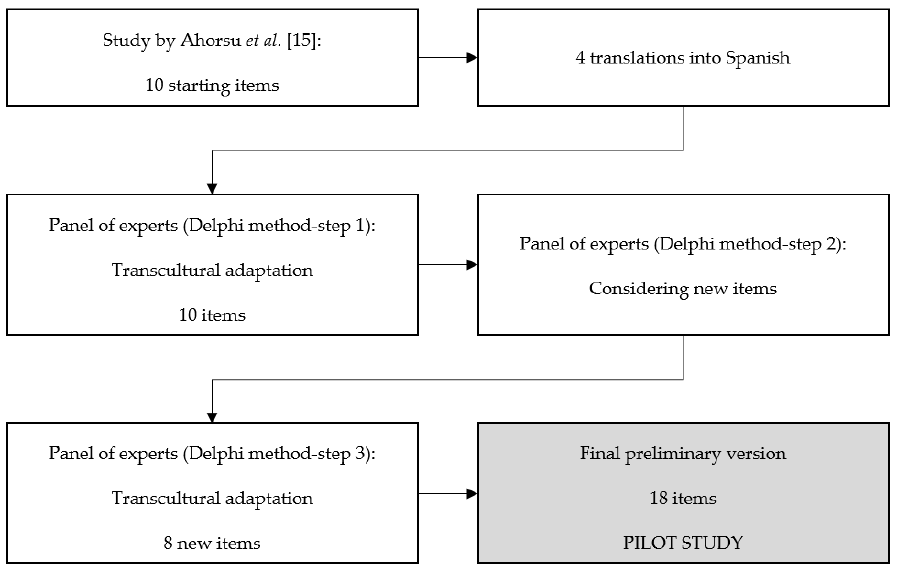
Figure 1. Stages of the questionnaire development